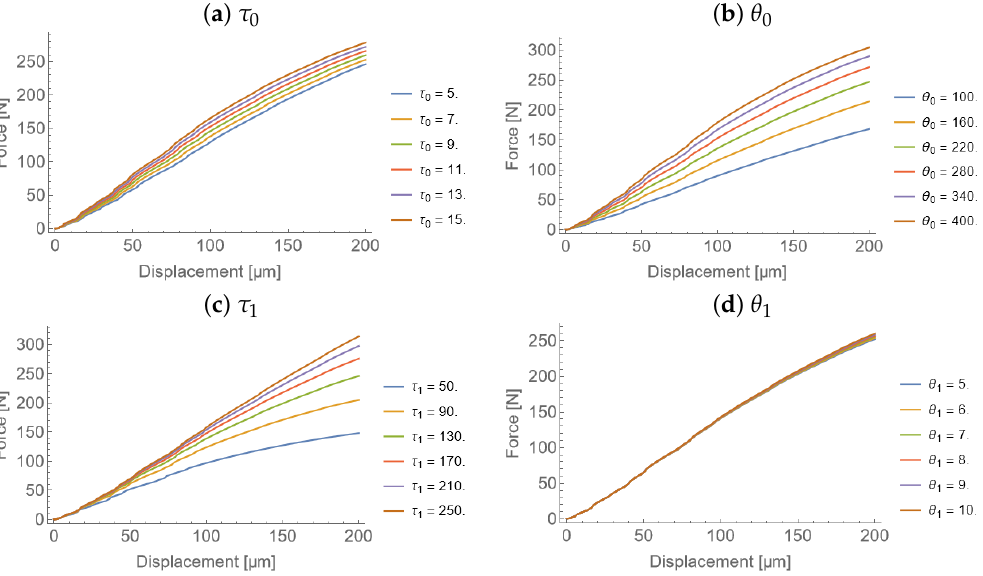
Figure 9. Sensitivity of LD curves to ( a ) τ 0 , ( b ) θ 0 , ( c ) τ 1 , and ( d ) θ 1 (other parameters were kept